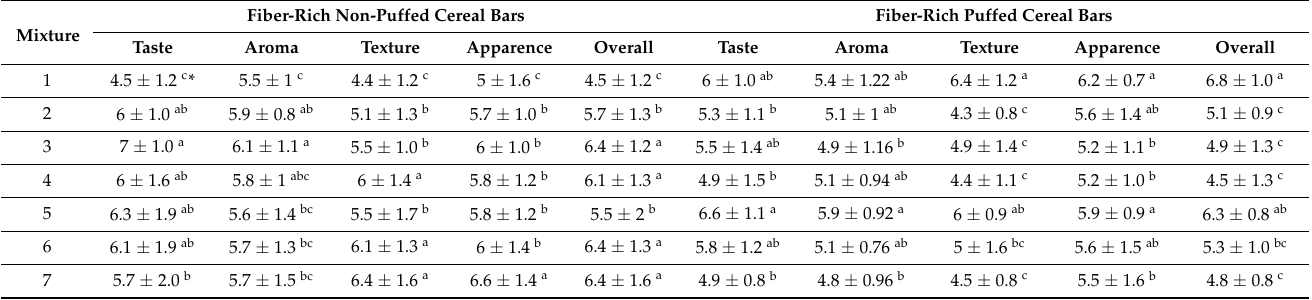
Table 5. Sensory properties of fiber-rich cereal bars with puffed and non-puffed cereals based on mixture